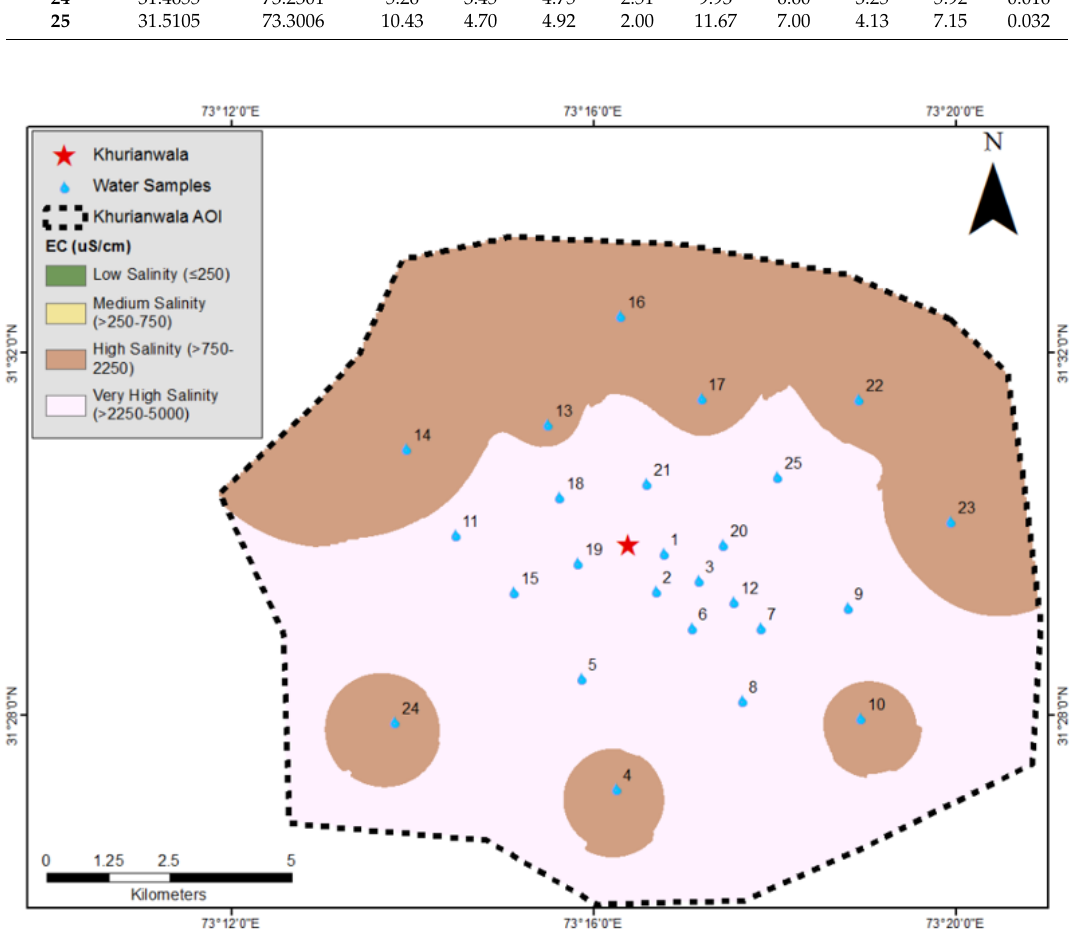
Figure 7. Mapping according to the distribution of electrical conductivity (EC) values based on drinking water quality standards and irrigation water quality